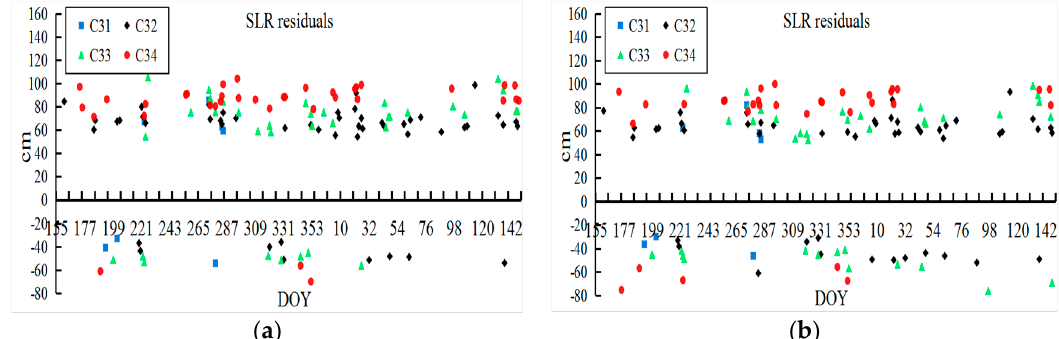
Figure 11. The SLR residuals of BDS-3 orbits based on NES and SS methods. ( a ) NES method, ( b ) SS method.